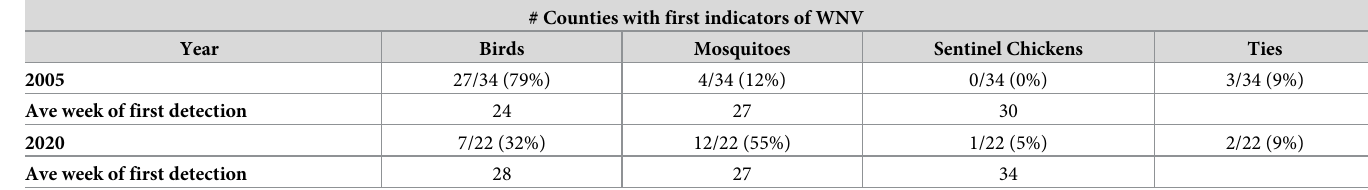
Table 6. Frequency of first detections of West Nile virus (from disease weeks 14–52) in counties with a detection in at least two of three environmental surveillance elements, and average disease week of first detections. (Due to rounding, total percentages are not 100%).